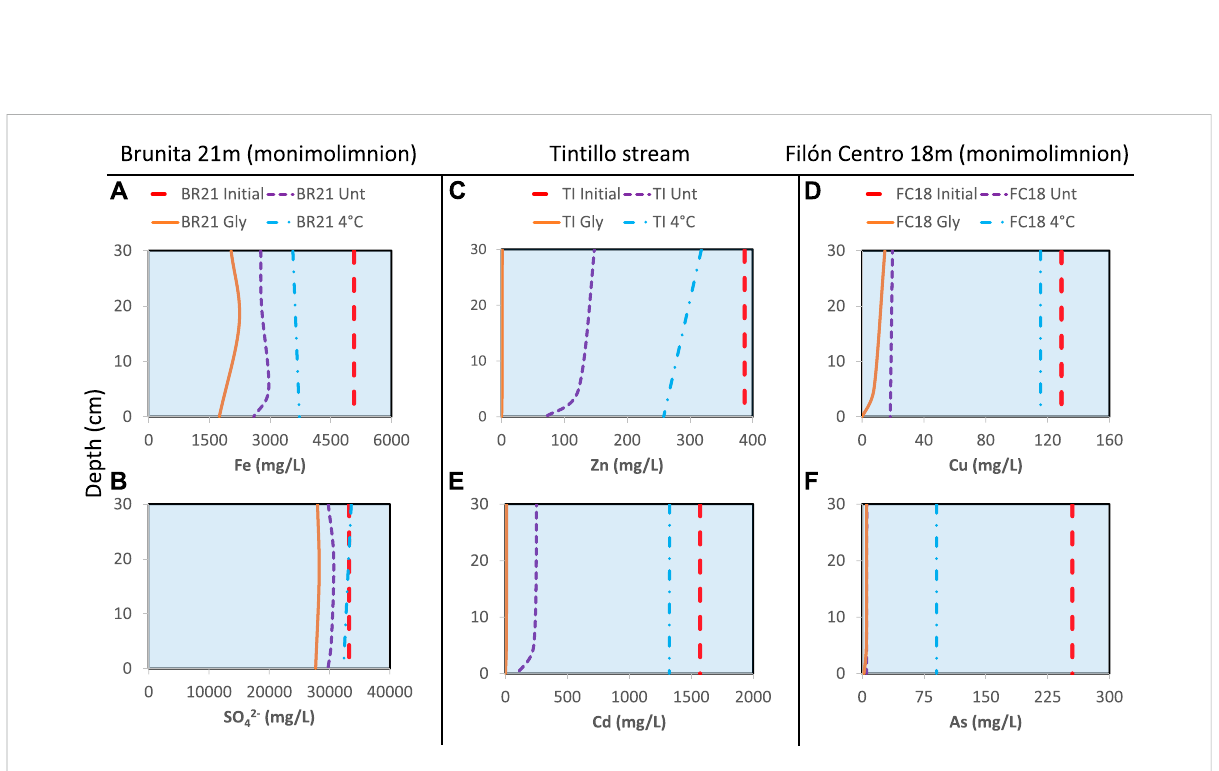
FIGURE 6 Metal concentration pro fi les obtained at different points of the water column overlaying the sediment. (A) Iron (B) sulfate (SO 4 2 − ) (C) zinc (D) copper (E) cadmium (F) arsenic. The concentration at the beginning of incubation (red dashed line) is compared to the concentration of these elements after 18 months of incubation with different treatment: untreated (dashed violet line), amended (solid orange line) and 4 ° C (dash-dotted blue